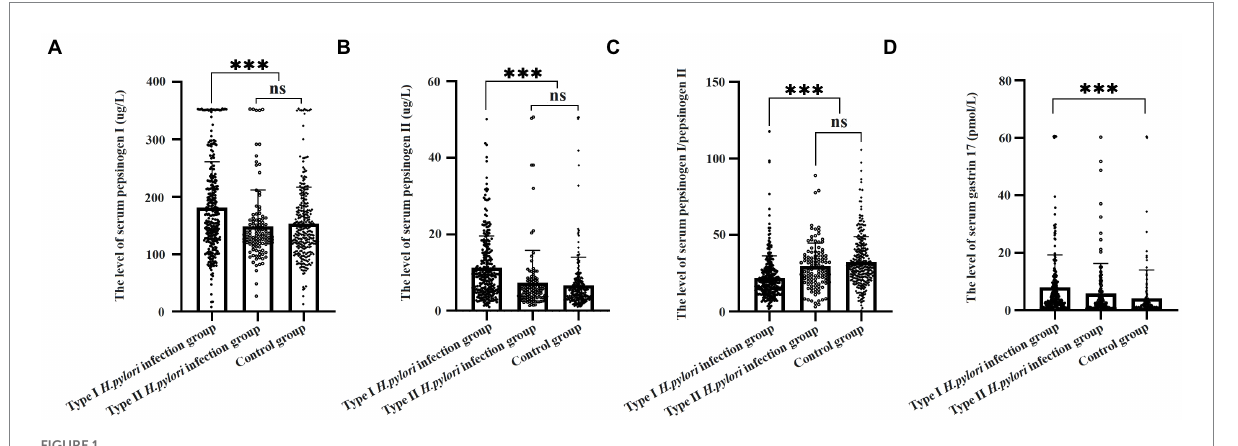
FIGURE 1 Serum gastric function of different types of Helicobacter pylori infection.